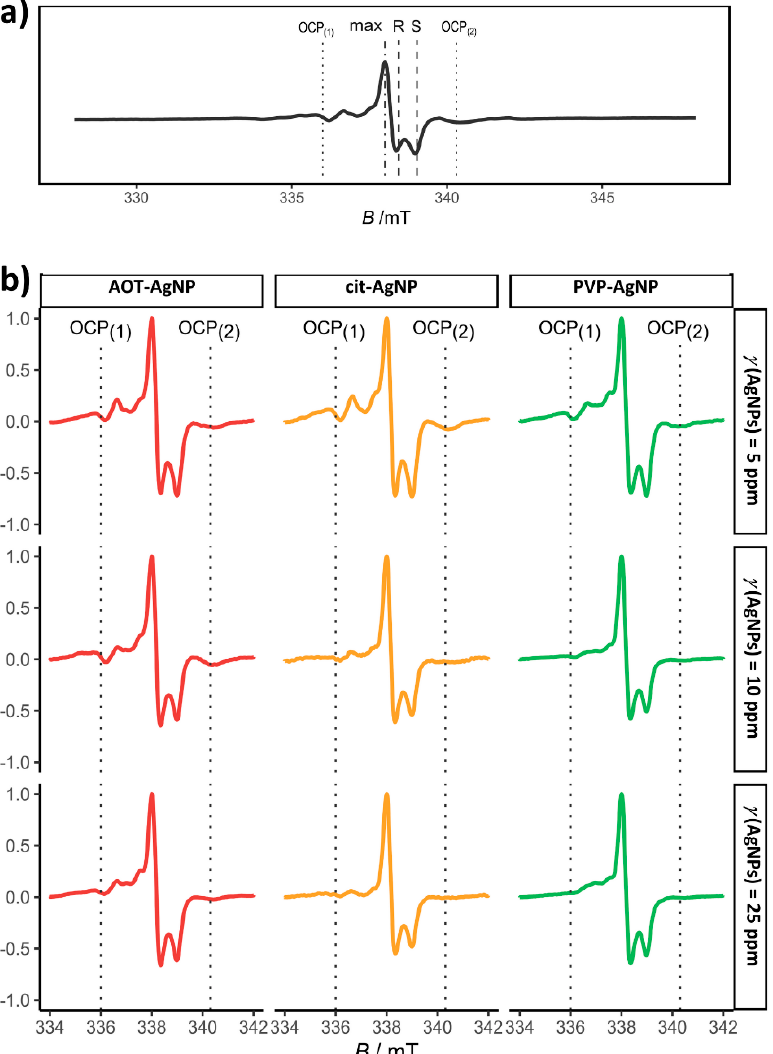
Figure 10. EPR spectra of ( a ) the precipitate obtained after 60 min reaction time in the control system and ( b ) the precipitates obtained after 60 min reaction time in the presence of different concentrations of silver nanoparticles (AgNPs) stabilized with citrate (cit-AgNPs), poly(vinylpyrrolidone) (PVP- AgNPs), and sodium bis(2-ethylhexyl) sulfosuccinate (AOT-AgNPs). c (CaCl 2 ) = c (Na 2 HPO 4 ) = 4 · 10 − 3 mol dm − 3 , pH 7.4, 25 ◦